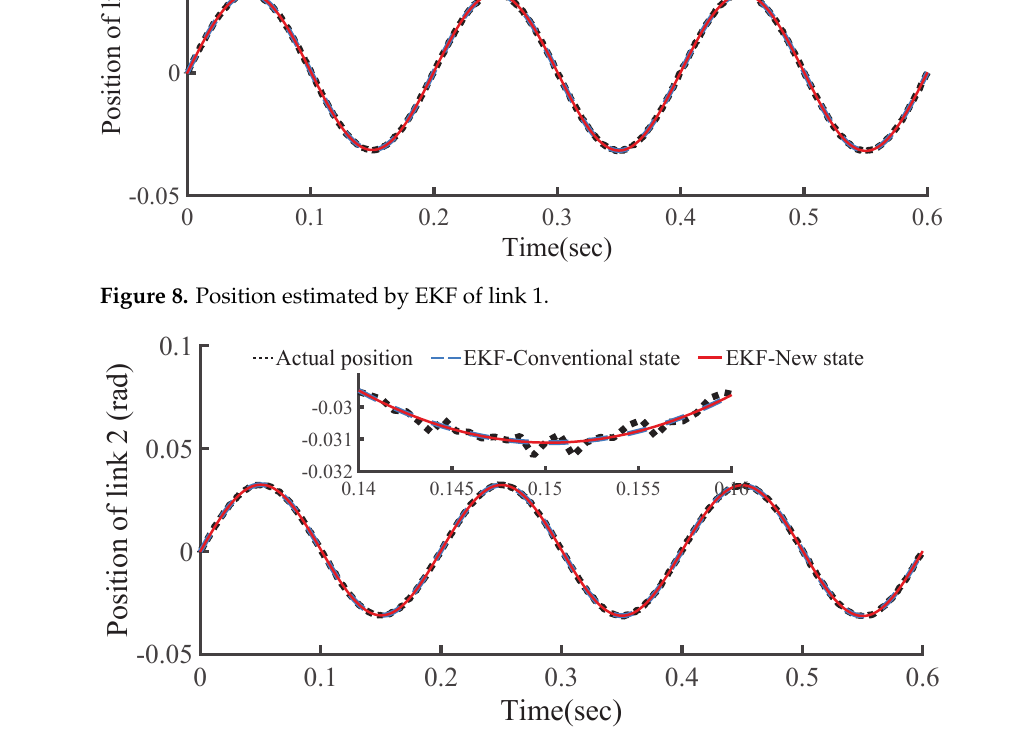
Figure 9. Position estimated by EKF of link